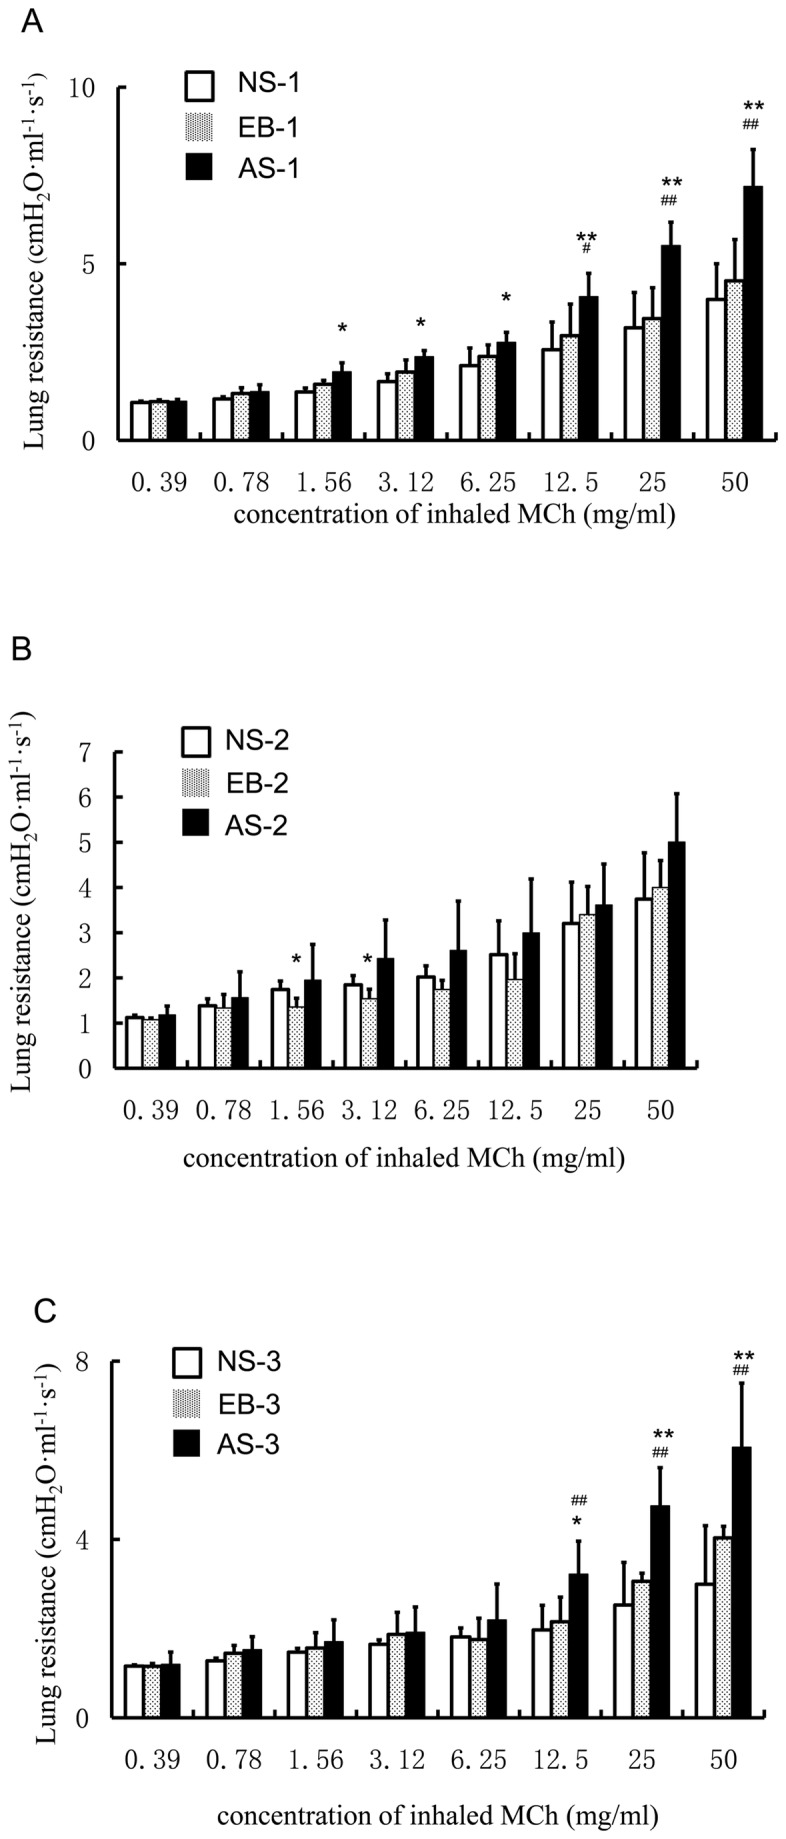
Changes in airway responsivenessin response to challenge with aerosolized methacholine.(A) Changes in lung resistance (RL) were recorded for 3 min after challenge with aerosolized methacholine on day 24, 24 h after the 1st intranasal OVA challenge, for 20 sec at the indicated doses. Mice received 3 intraperitoneal injections of 10 µg of ovalbumin (OVA) emulsified with 1.3 mg of aluminum hydroxide on days 0, 7, and 14. They were then intranasally challenged with 10 (the EB-1 group) or 200 µg aerosolized OVA (the AS-1 group) for 3 consecutive days on days 21 to 23. The control mice received an equivalent volume of normal saline for sensitization and intranasal challenge. *P<0.05 and ** P<0.01, the AS-1 group vs. the NS-1 group; #
P<0.05 and # #
P<0.01, the AS-1 group vs. the EB-1 group. (B) Changes in airway reactivity in response to a second challenge with aerosolized methacholine. Changes in RL were recorded for 3 min after challenge with aerosolized methacholine on day 45, 3 weeks after the first intranasal challenge, for 20 sec at the indicated doses. *P<0.05, the EB-2 group vs. the NS-2 group. (C) Changes in airway reactivity in response to challenge with aerosolized methacholine following the 2nd intranasal OVA challenge. Changes in lung resistance (RL) were recorded for 3 min after challenge with aerosolized methacholine on day 49, 24 h after the 2nd intranasal OVA challenge, for 20 sec at the indicated doses. *P<0.05 and ** P<0.01, the AS-3 group vs. the NS-3 group; #
P<0.01, the AS-3 group vs. the EB-3 group.